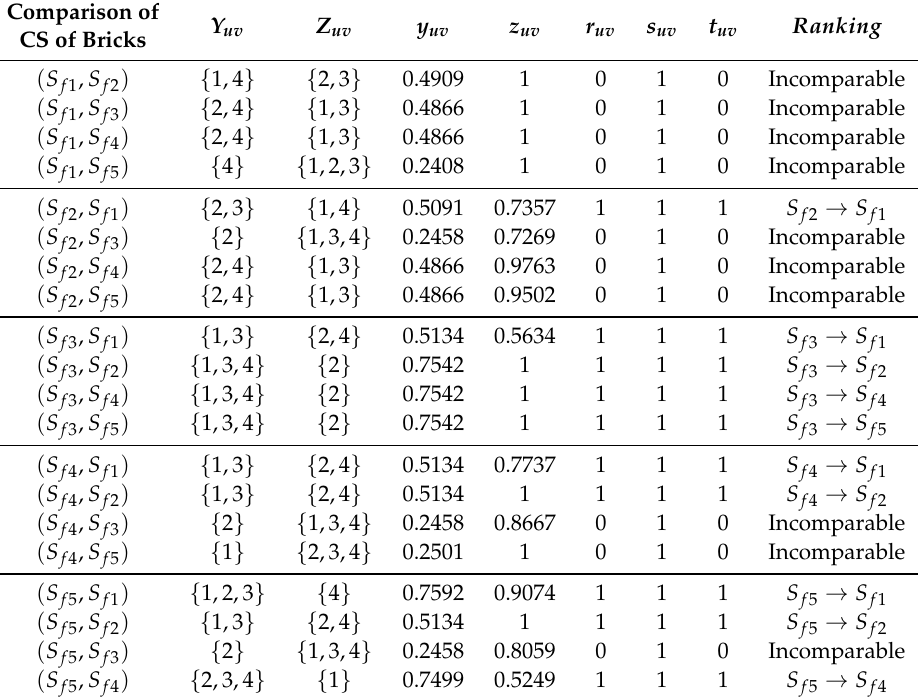
Table 14. Tabular representation of comparison of sites for